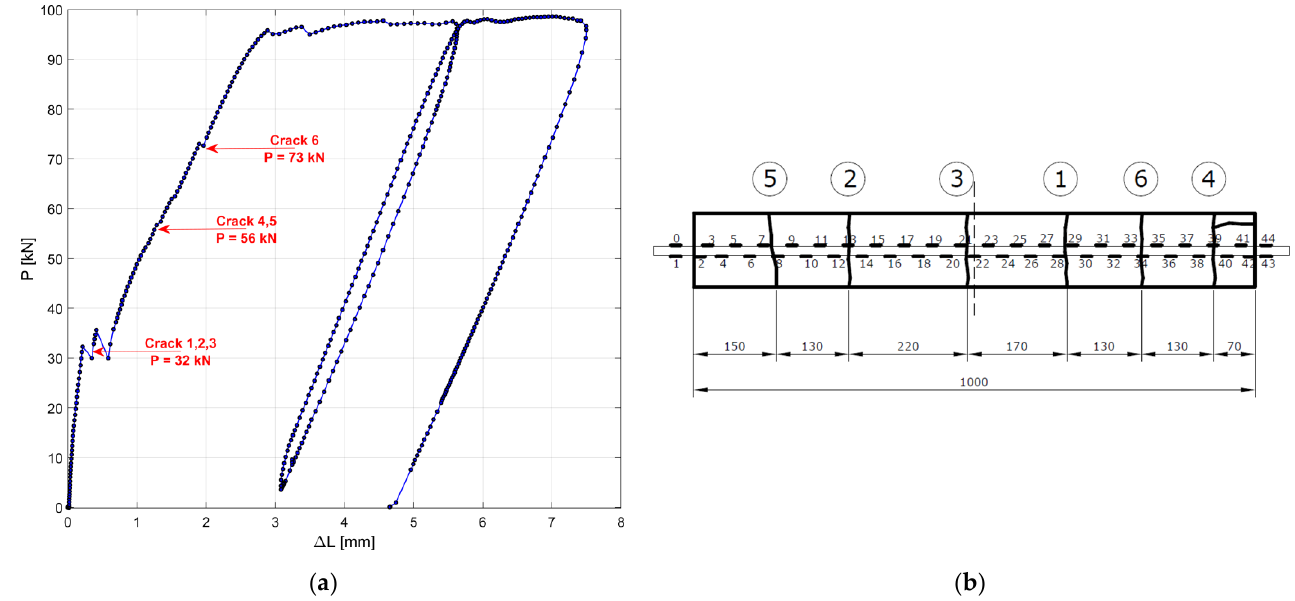
Figure 12. Experimental load–displacement diagram specimen n.1 ( a ), and location of the six cracks numbered according to the sequence of occurrence (unit: mm) ( b ).